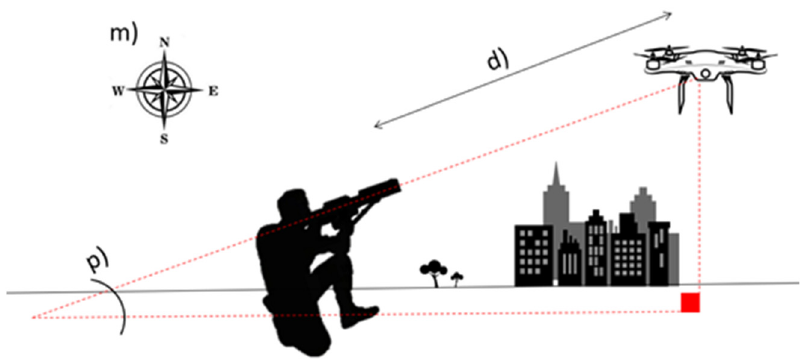
Figure 5. UAV localization method.